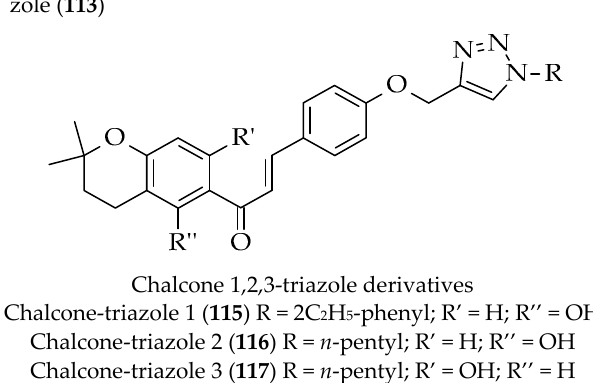
Figure 12. Structures of some synthetic antidiabetic chalcones.